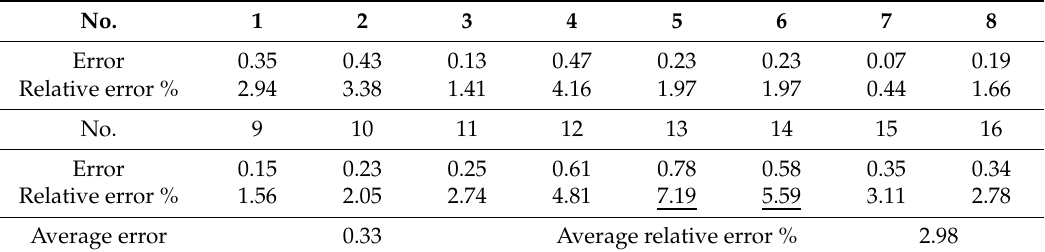
Table 9. Prediction error of M 6400 .